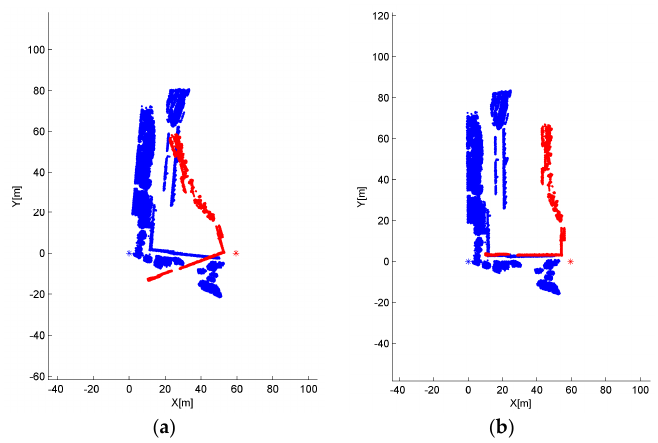
Figure 13. The IME result of S1–S6: ( a ) the Nadir view corresponding to the minimum entropy, which is a local convergence for IME; and ( b ) the theoretically correct posture for S1 and S2, which corresponds to the fifth small entropy. Table 6. Errors between estimated and reference transformation parameters.